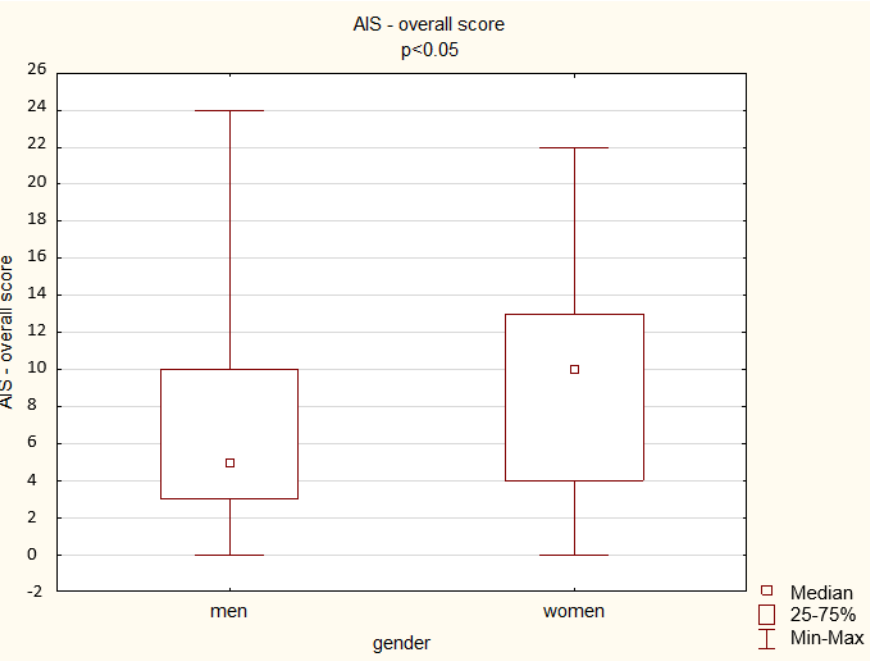
Figure 10. Hospitalized patient results in the AIS — overall score (Mann – Whitney U test). A comparison of the results obtained by the non-hospitalized men and women in the AIS shows a significant difference depending on gender only in one aspect of the questionnaire: women achieved a higher score in total sleep time ( p < 0.01) (Figure 11).